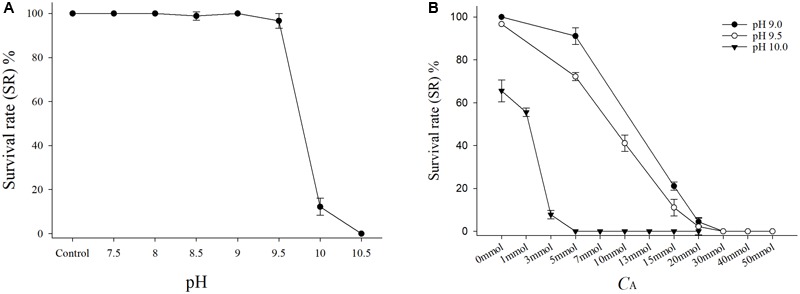
(A) Survival rate of juvenile of Sinonovacula constricta (JSCs) with different pH values under the same CA in the acute toxicity test. Bars represent the mean ± SE (n = 3). The control group was normal artificial seawater (ASW) with no adjustments to the pH and CA. (B) Survival rates of JSCs with different CA levels under the same pH in the acute toxicity test. Bars represent the mean ± SE (n = 3).